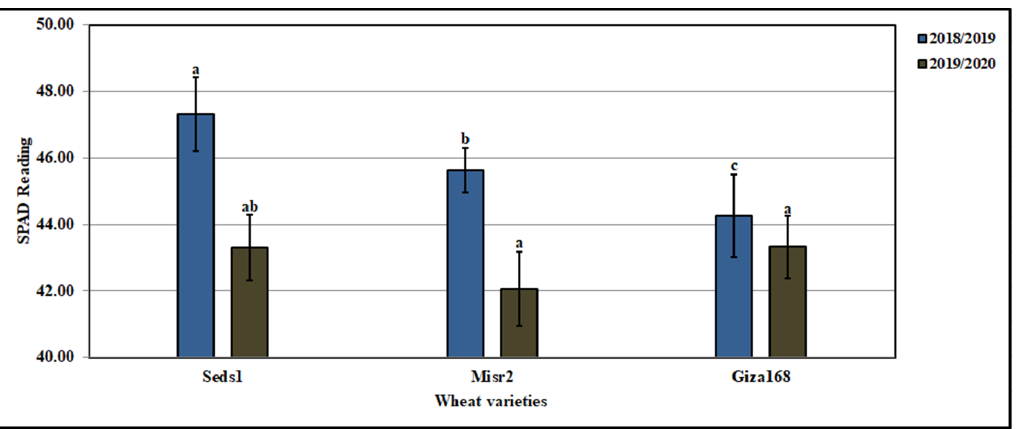
Figure 6. Influence of wheat varieties on SPAD reading in clay loam soil in 2018/2019 and 2019/2020 seasons. Bars in the same years with a different letter indicate significant differences between treatments at p ≤ 0.01.